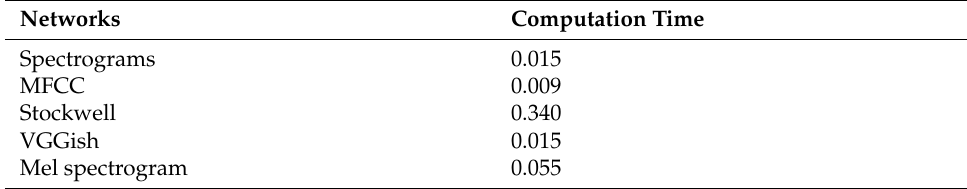
Table 9. Computation times (seconds) for representing audio file as an